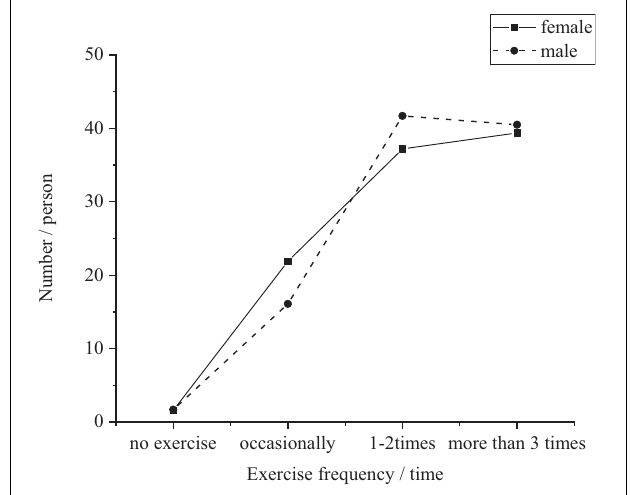
FIGURE 1 | Statistics of weekly physical exercise frequency for boys and